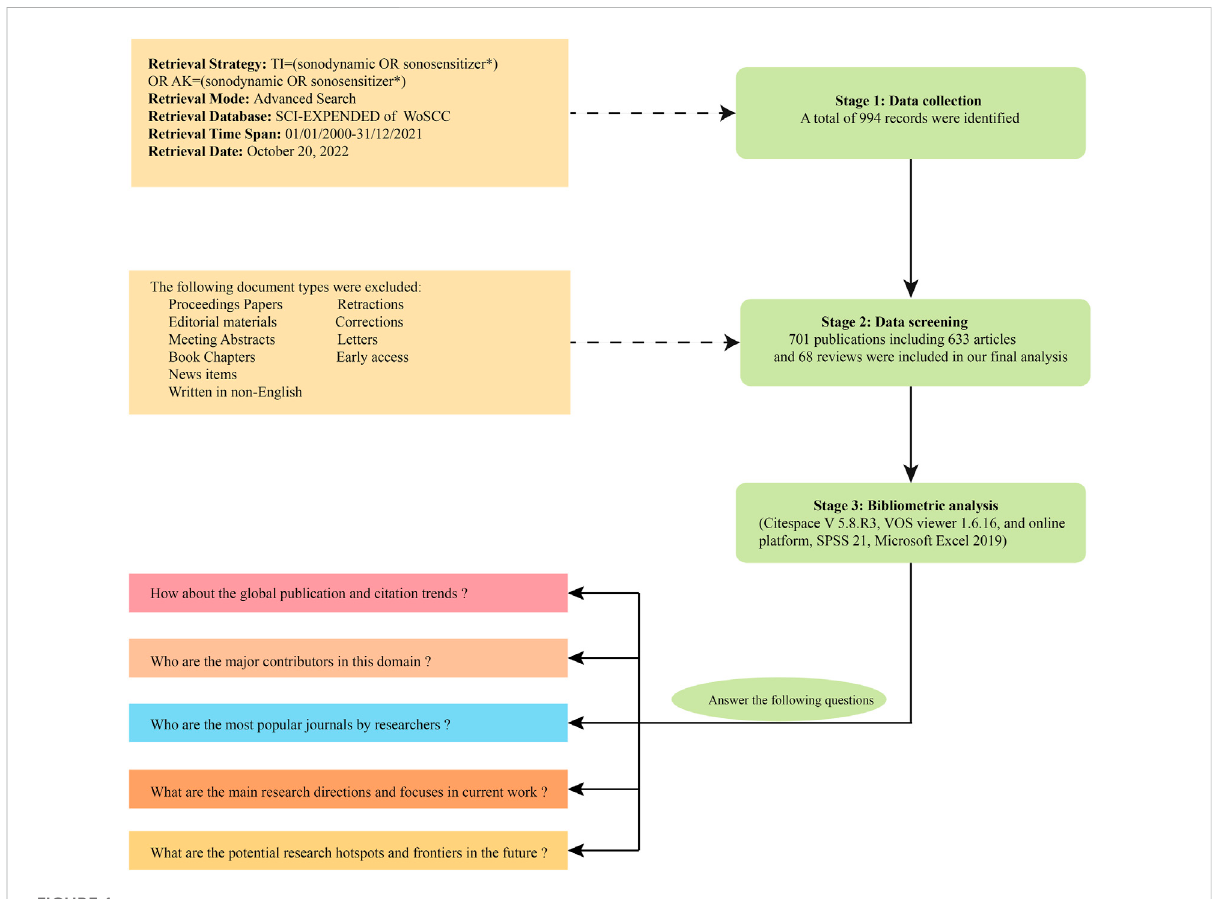
FIGURE 1 Flowchart of literature screening and data